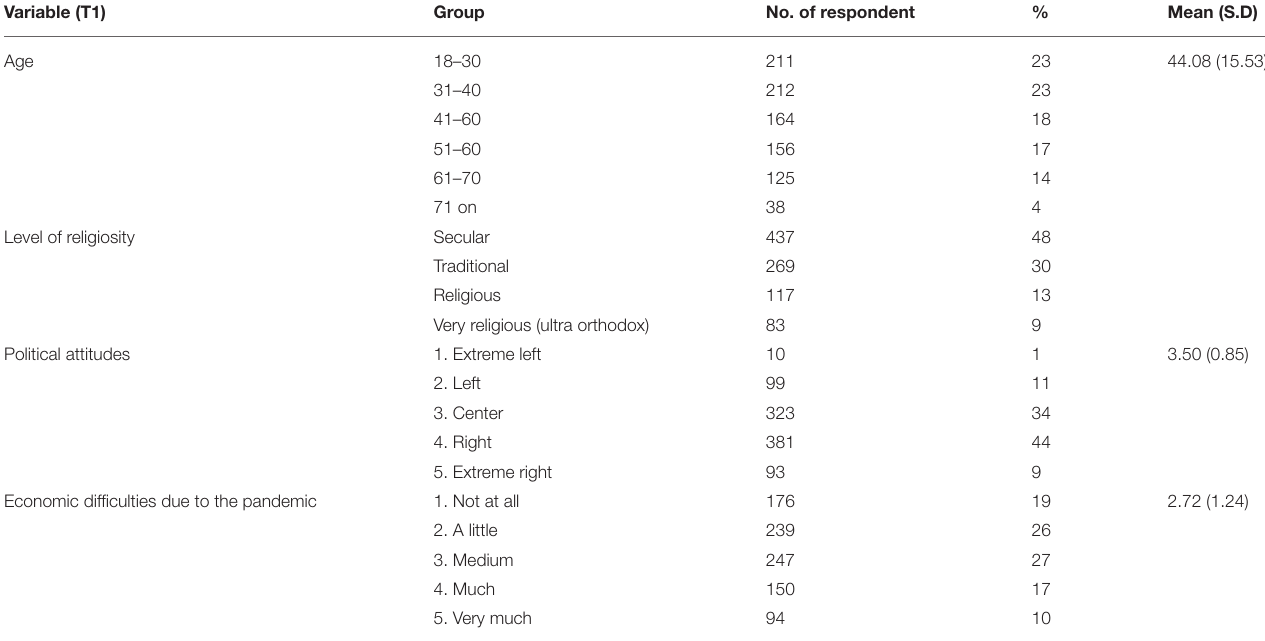
TABLE 1 | Demographic characteristics of the respondents ( N = 906). Variable